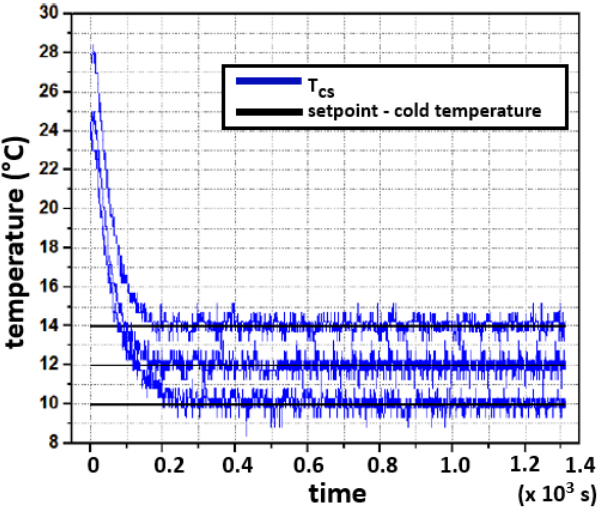
Figure 15. Three testing setpoints for the experimental closed-loop response for the cold